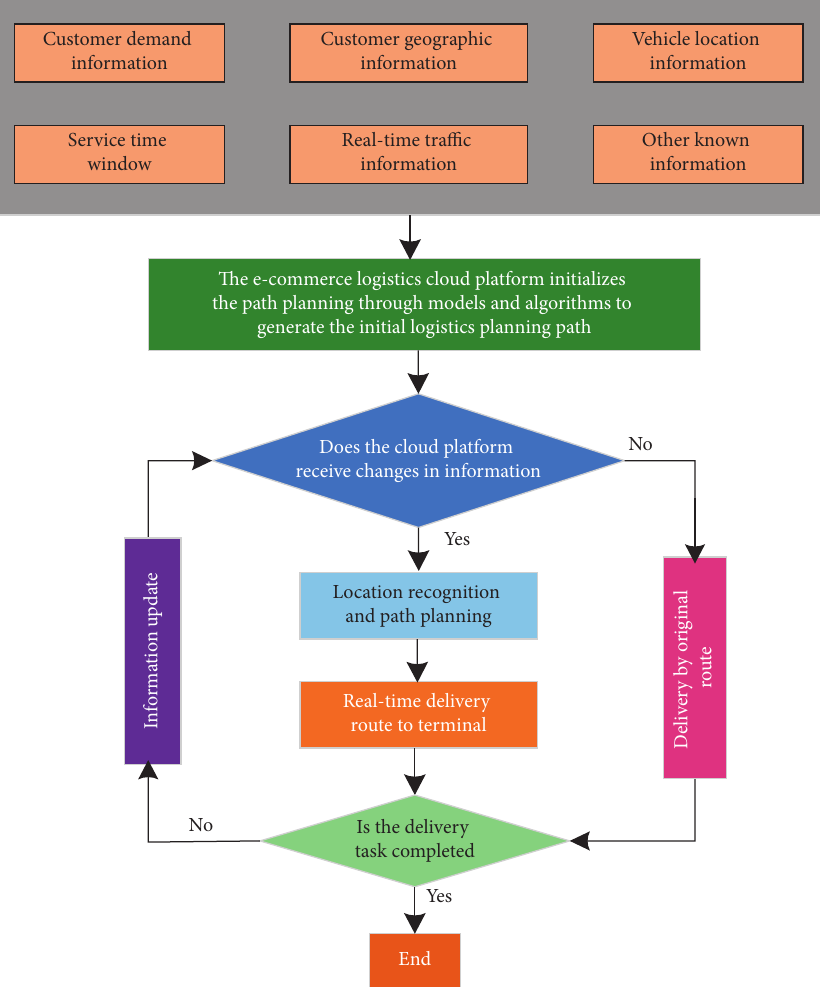
Figure 6: Distribution process in e-commerce logistics